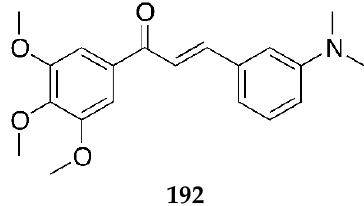
Figure 63. Chemical structure of N,N -dimethyl-3′-aminochalcone with methoxy substitutions on ring A.